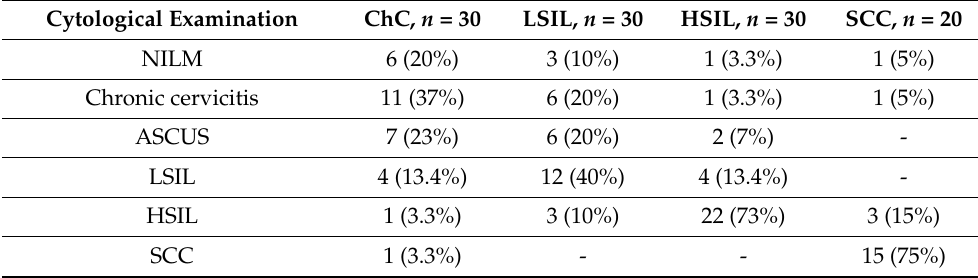
Table 2. Results of cytological examination.